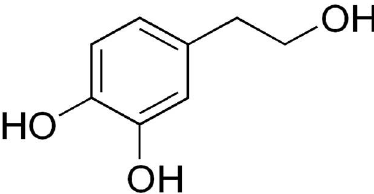
Figure 1. Structure of Hydroxytyrosol, 3,4-dihydroxyphenylethanol (DOPET). IUPAC name: 4-(2- Hydroxyethyl)-1,2-benzenediol.